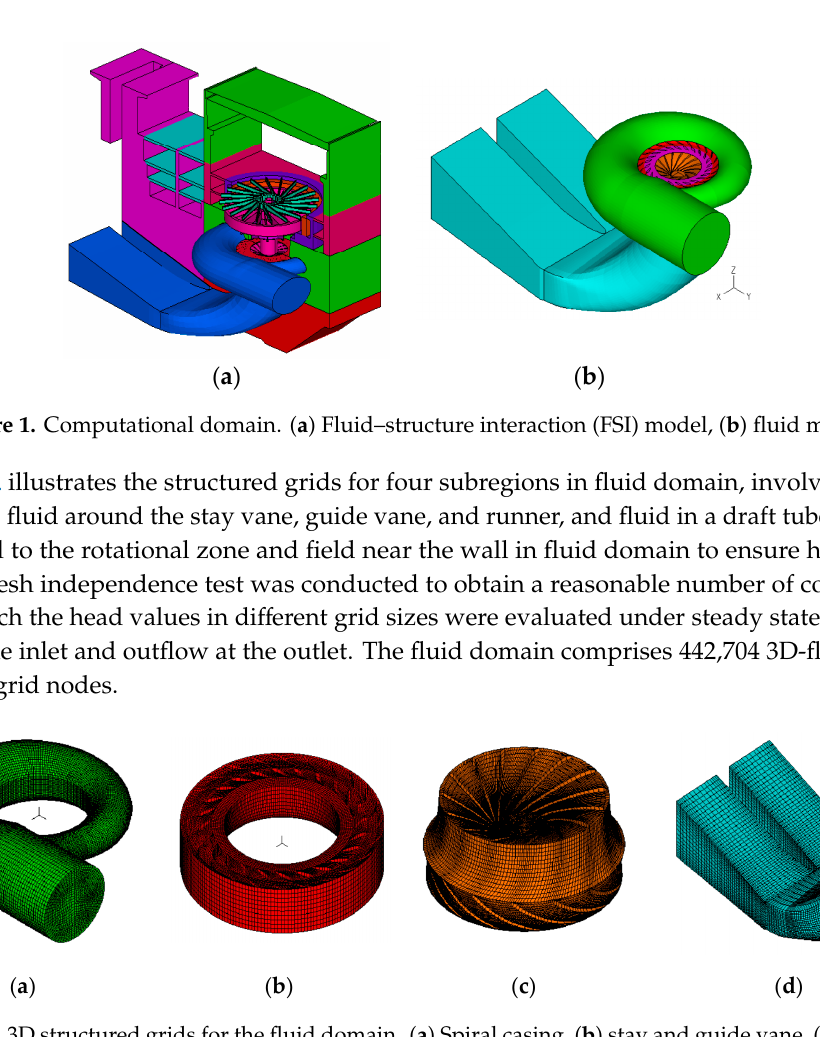
Figure 2. 3D structured grids for the fluid domain. ( a ) Spiral casing, ( b ) stay and guide vane, ( c ) runner, ( d ) draft tube.